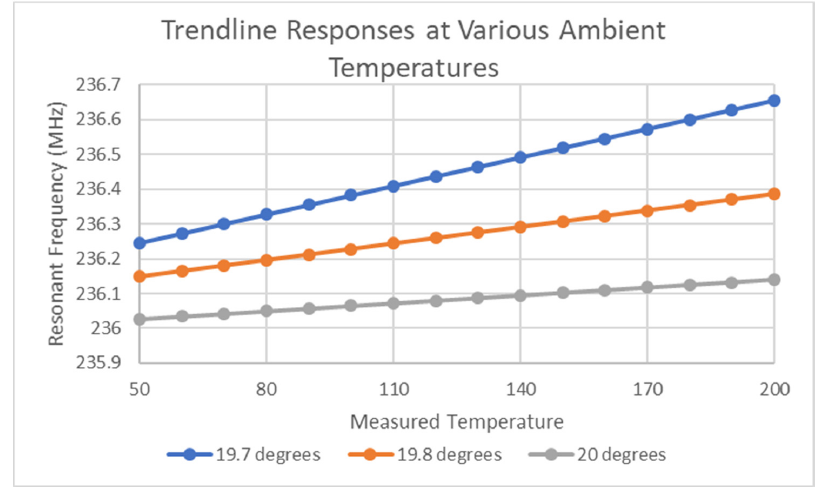
Figure 10. Trendline plots for various temperatures.